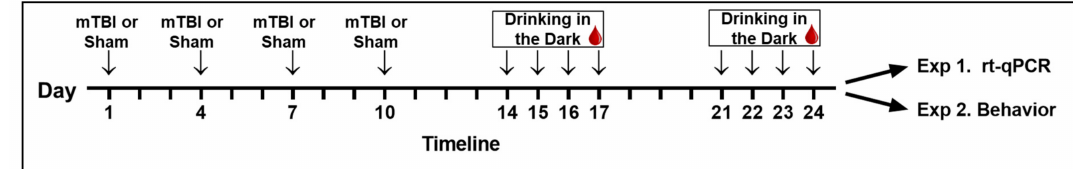
Figure 1. Timeline detailing the mild repetitive traumatic brain injury (rmTBI) or sham protocol and subsequent drinking in the dark (DID)